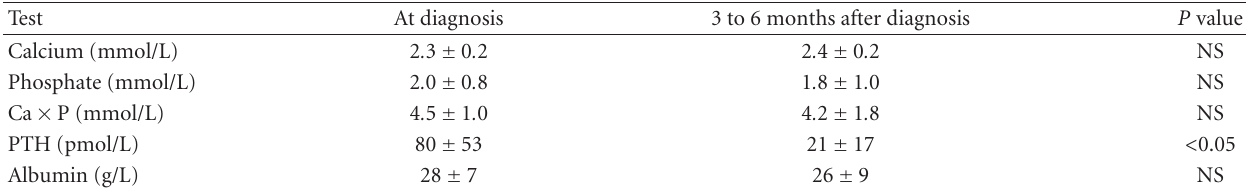
Table 2: Comparison of biochemical profile of subjects with calciphylaxis at diagnosis and within 6 months after the diagnosis. Test At diagnosis 3 to 6 months after diagnosis P value Calcium (mmol/L) 2 . 3 ± 0 . 2 Phosphate (mmol/L)